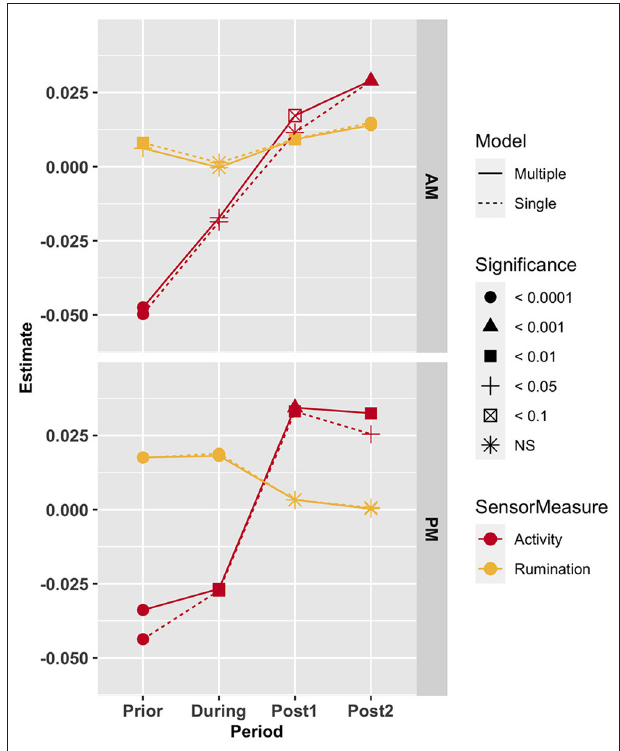
FIGURE 2 | Estimated effects of adjusted activity (red) and rumination (yellow) in the period prior to feeding (Prior), the period during which feeding occurs (During) and the two consecutive periods following feeding (Post1 and Post2). Line type denotes whether single sensor measures (activity or rumination) or both sensor measures (activity and rumination) were included in the model. The shape of the points indicates the significance level of the